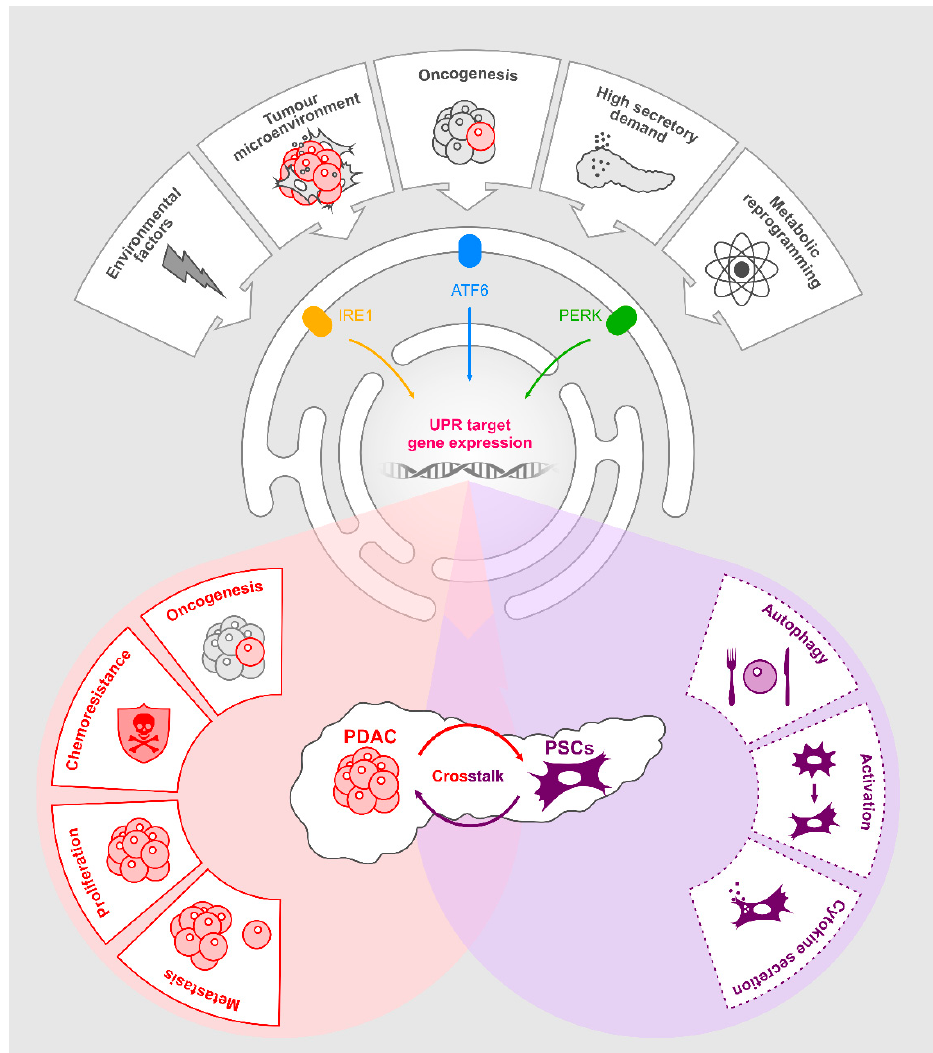
Figure 2. The Role of unfolded protein response (UPR) in pancreatic ductal adenocarcinoma (PDAC).Various stresses including environmental factors, the tumour microenvironment, oncogenesis, high secretory demand and metabolic reprogramming activate the UPR in pancreatic cancer. This results in upregulation of UPR gene targets. Many of these gene promote oncogenic pathways in PDAC cells. UPR activation promotes a pro-tumorigenic pancreatic stellate cell (PSCs) phenotype. Paracrine signalling from PDAC cells and PSCs, as a consequence of UPR activation in PDAC, also promotes tumorigenic behaviours.